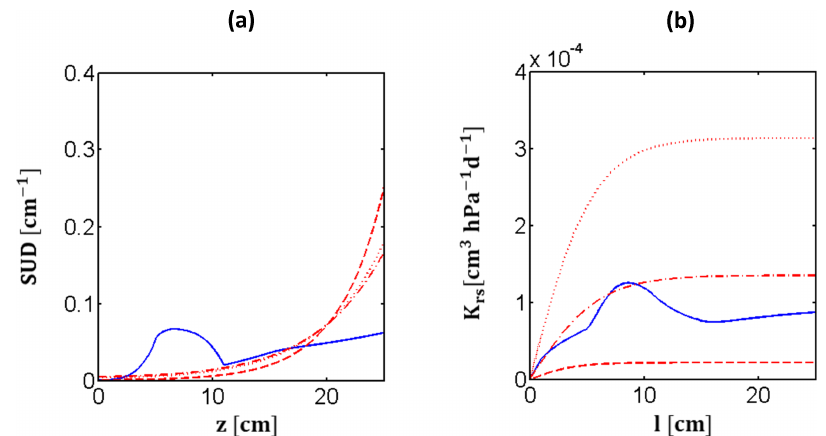
Figure 8. Macroscopic parameters: final SUD (a) and K rs changes (b) for a growing maize lateral root with the local hydraulic properties estimated by Doussan et al. (1998b) (blue solid line) or the equivalent uniform roots (red lines) with minimal (dashed), maximal (dotted) or mean (dashed-dotted) hydraulic property values. The colour legend is the same as in the previous